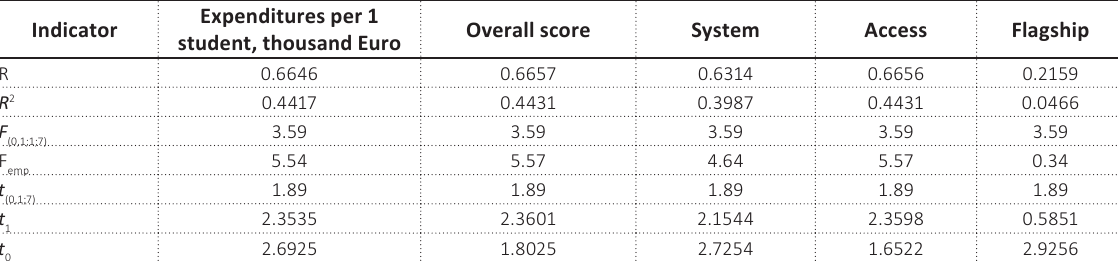
Table 5. Analysis of the correlation between expenditure per student and the components of the QS World University